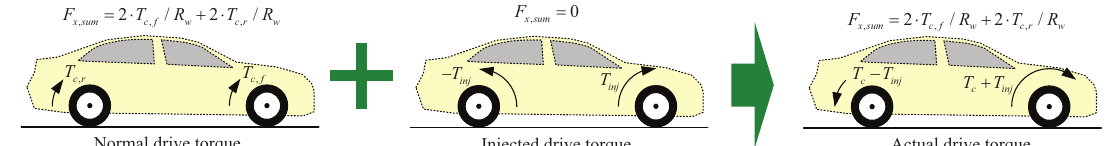
Figure 12. Principles of torque injection.